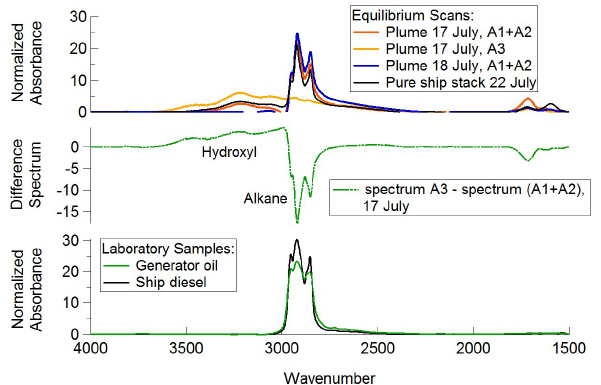
Fig. 8. Size-resolved concentrations of AMS organic, and the or- ganic markers m/z 57 and m/z 43 for 17 July (a) and 18 July (b) . The small particle mode is clearly visible on 17 July. The marker m/z 57 only appears in the large particle mode, the marker m/z 43 in both